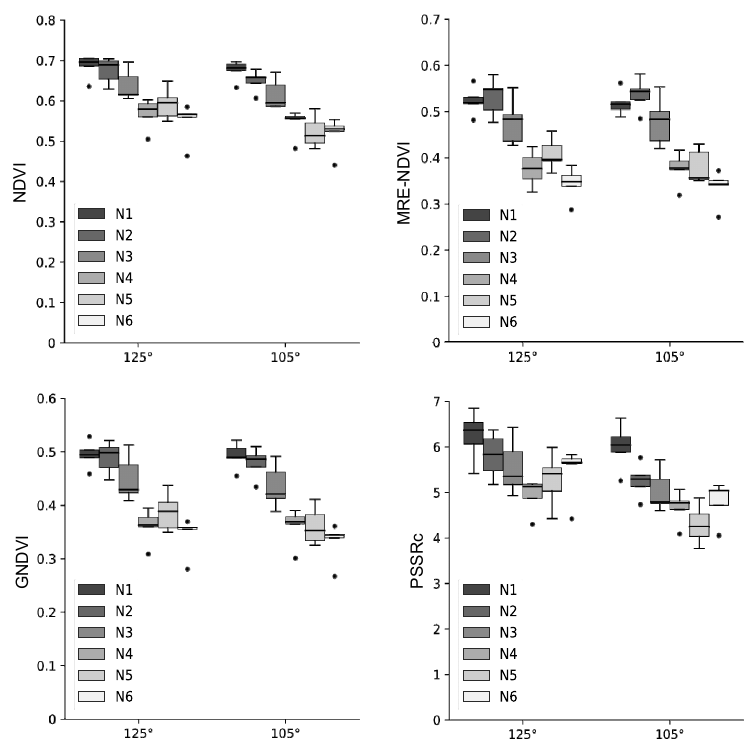
Figure 4. Variation of vegetation indices by the shooting angles for taking the hyperspectral images. Vegetation indices were calculated with spectral reflectance of the base region in the 2nd uppermost leaf. In the box plots, the bottom and top of the box describe the 25th and 75th percentiles, the band near the middle of the box is the 50th percentile (the median); the ends of the whiskers represent the minimum and maximum of the data. The black circle dots indicate outliers.